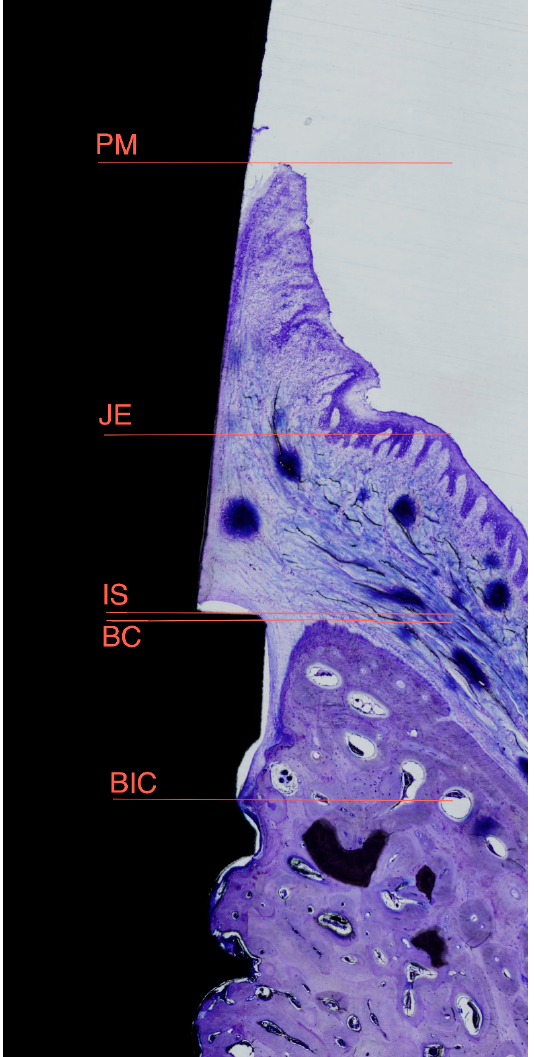
Figure 4. Diagrams representing landmarks used for histometric evaluation: PM, top of the Peri-implant Mucosa; JE, apical portion of the Junctional Epithelium; IS, Implant Shoulder; BC, Bone Crest; and, BIC, first point of Bone-to-Implant Contact.